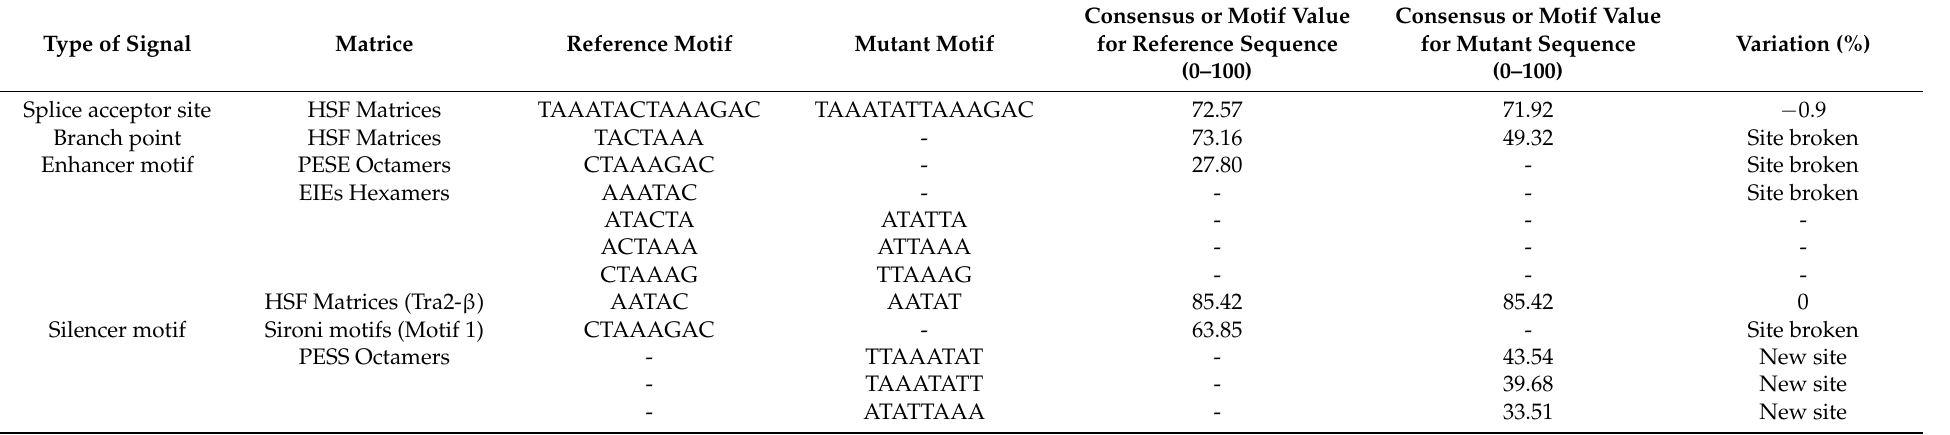
Table 4. Potential splicing regulatory sequences in wild-type and mutant type of rs4149153 by Human Splicing Finder (HSF)